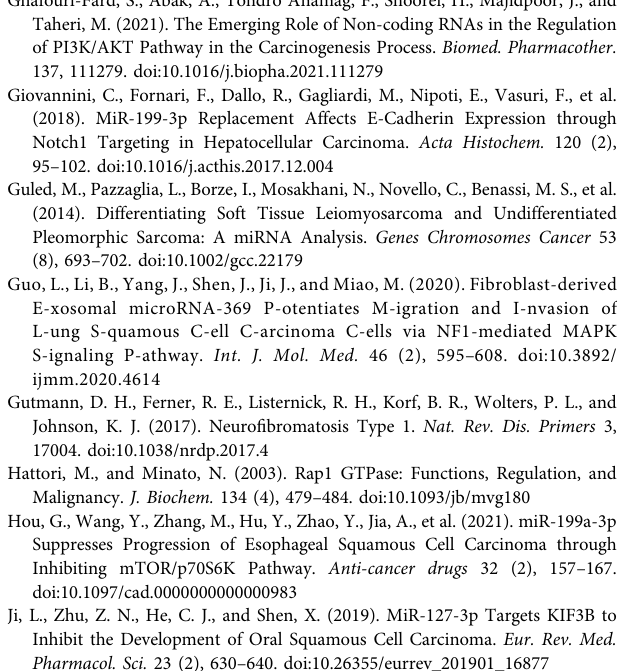
Supplementary Figure S1 | Size distribution and annotation of small RNAs from theadjacentnormal tissue and UPStissue.Theproportionsofvarious kindsofsmall RNAs detected in the adjacent normal tissue (A) and UPS tissue (B) . (C) Frequency percent of length distribution (nt) of the annotated reads of the miRNAs from the adjacent normal tissue and UPS